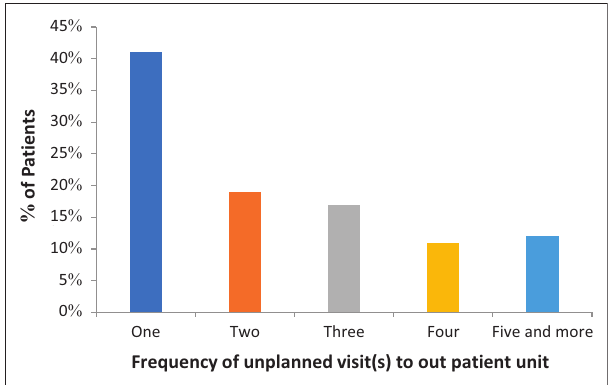
FIGURE 3: Frequency of unplanned visits to outpatient unit by cancer patients (501) during the study period.